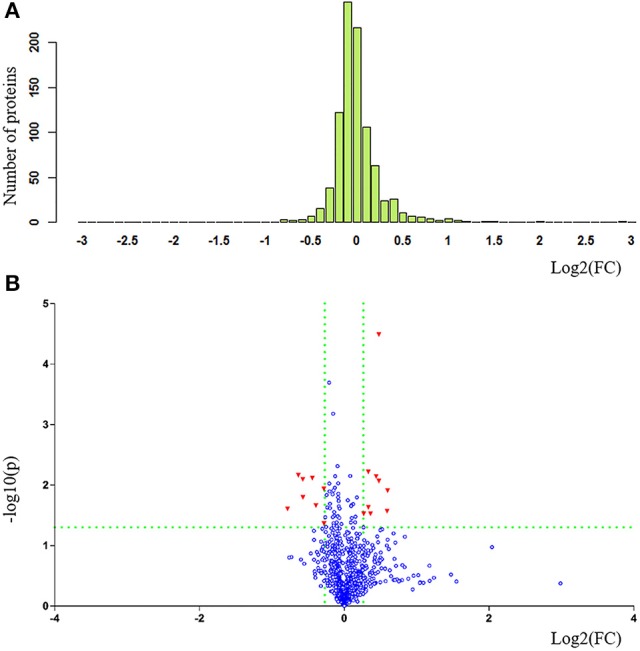
Statistical comparison and exhibition of proteins between patients with PDD and PD in proteomics analysis. (A) Protein ratio distribution and (B) volcano plot. FC value was calculated as the ratio of the average mass response (area) between the two groups (FC value = PDD/PD). P-value was calculated using Mann-Whitney U-test. PDD, Parkinson's disease-related depression; PD, Parkinson's disease; FC, fold change.